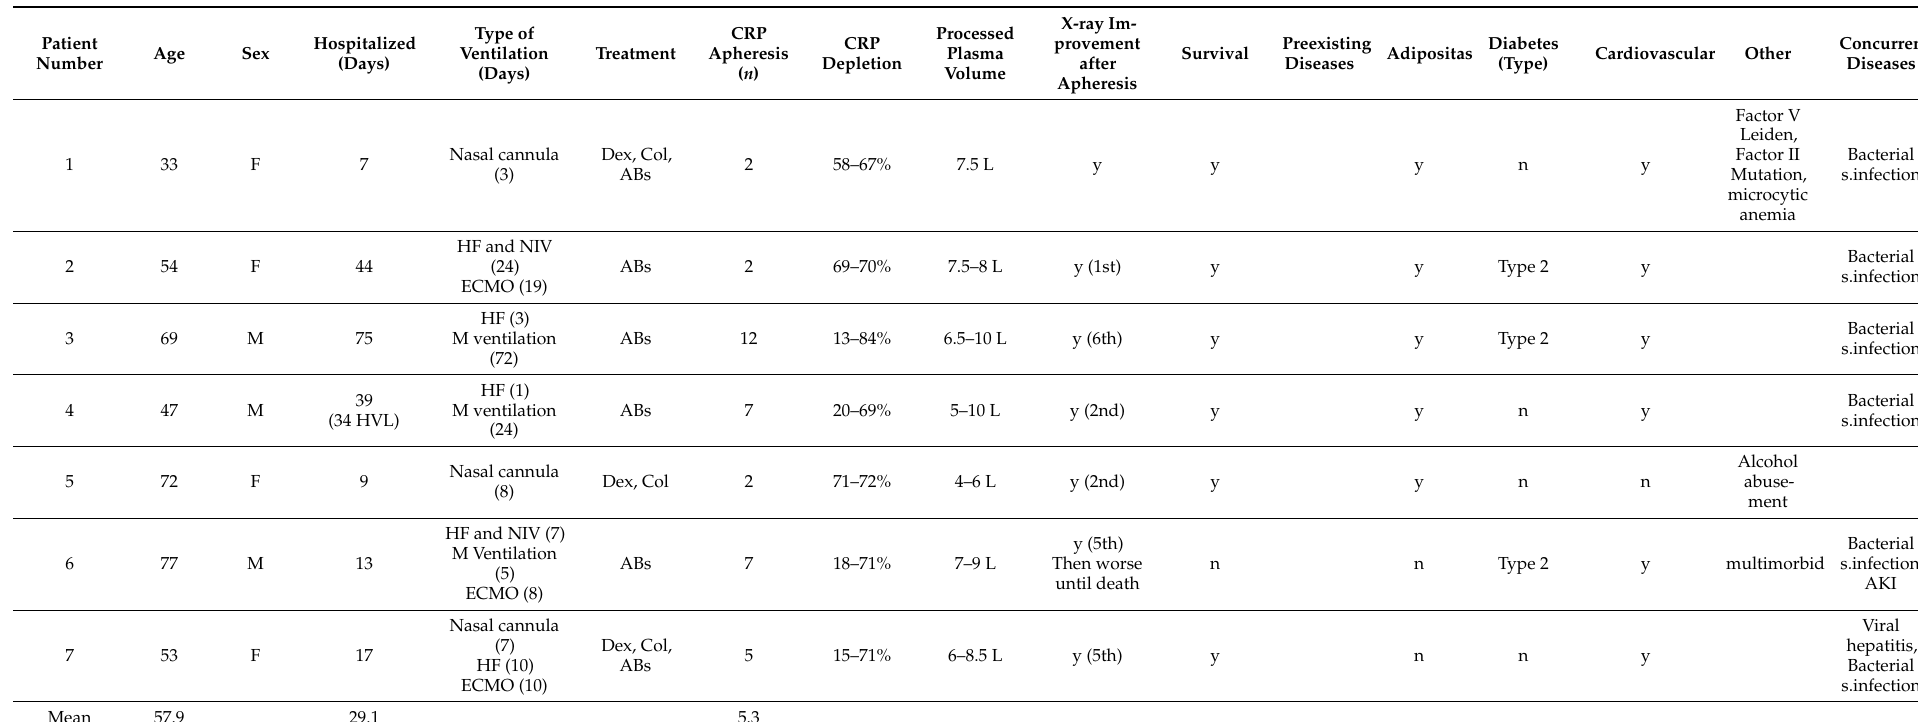
Table 1. Patient characteristics. The table shows age, sex, concomitant diseases, respiratory supply, in-hospital length of stay and treatment parameters of all 7 patients. All patients had documented SARS-CoV-2-induced pneumonia and showed signs of respiratory failure. Patient 6 had acute renal failure (AKI) shortly before his demise. F female, M male, HF High Flow, NIV non-invasive ventilation, M ventilation mechanical ventilation, y yes, n no, ECMO